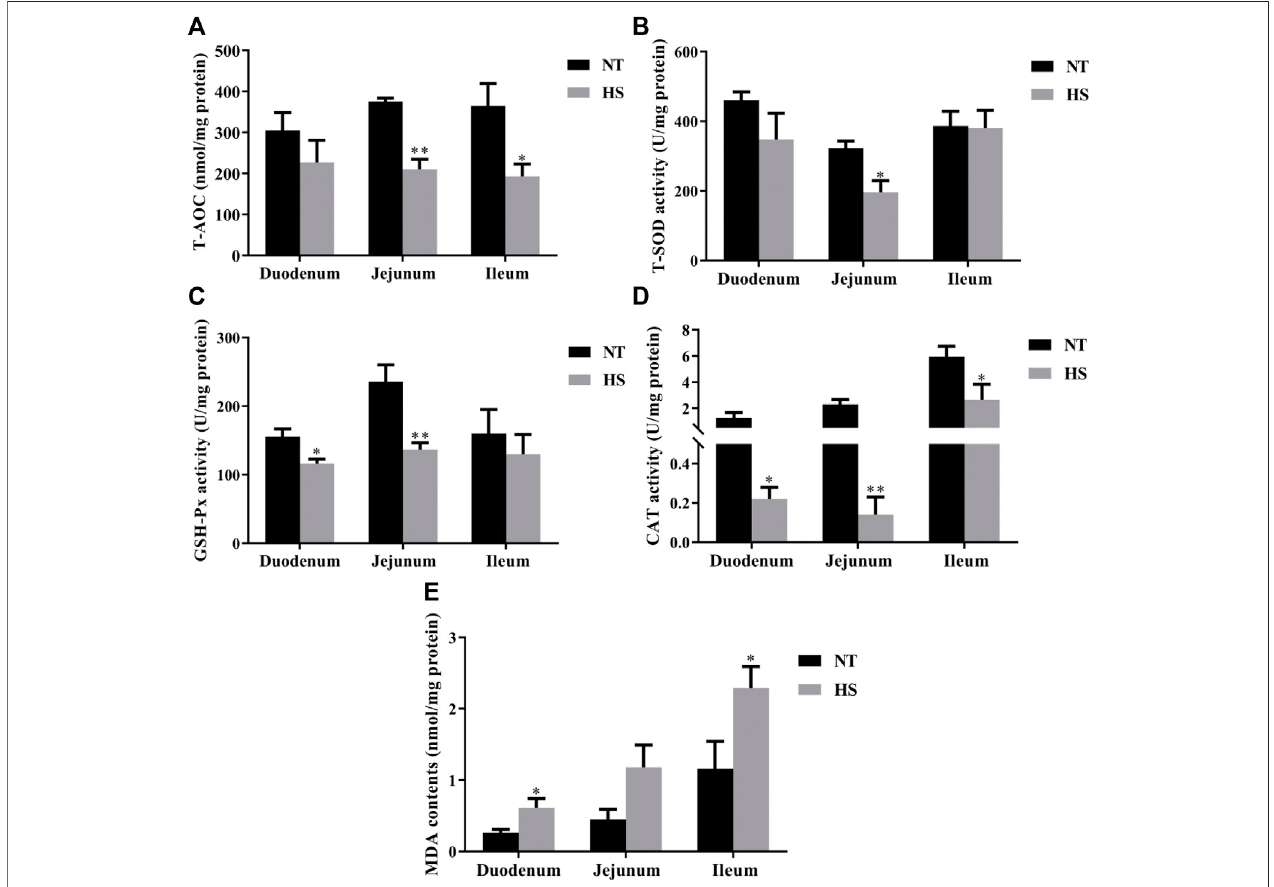
FIGURE 2 | Effects of heat stress on antioxidant capacity of duodenum, jejunum, and ileum in indigenous broilers (n = 5/group). T-AOC, total antioxidant capacity (A) . T-SOD, total superoxide dismutase (B) . GSH-Px, glutathione peroxidase (C) . CAT, catalase (D) . MDA, malondialdehyde (E) . NT, normal treatment group (21.3